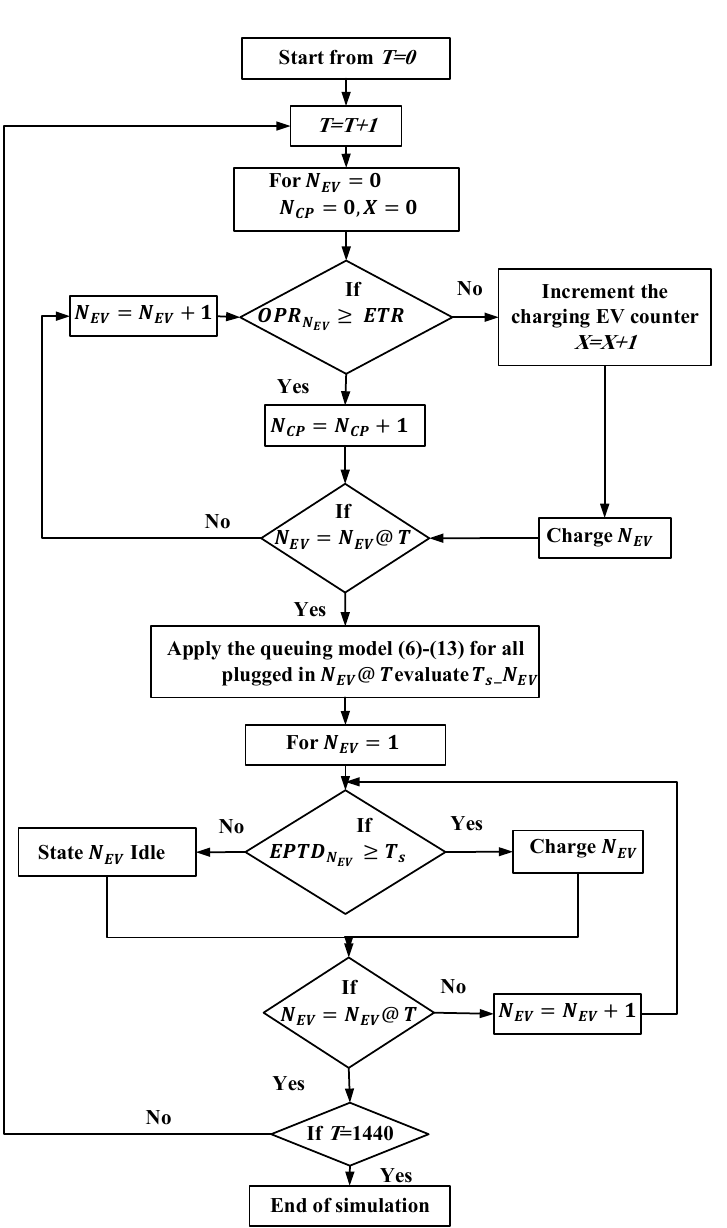
Figure 5. Flowchart of real-time EV queue charging based on owner’s preferences.